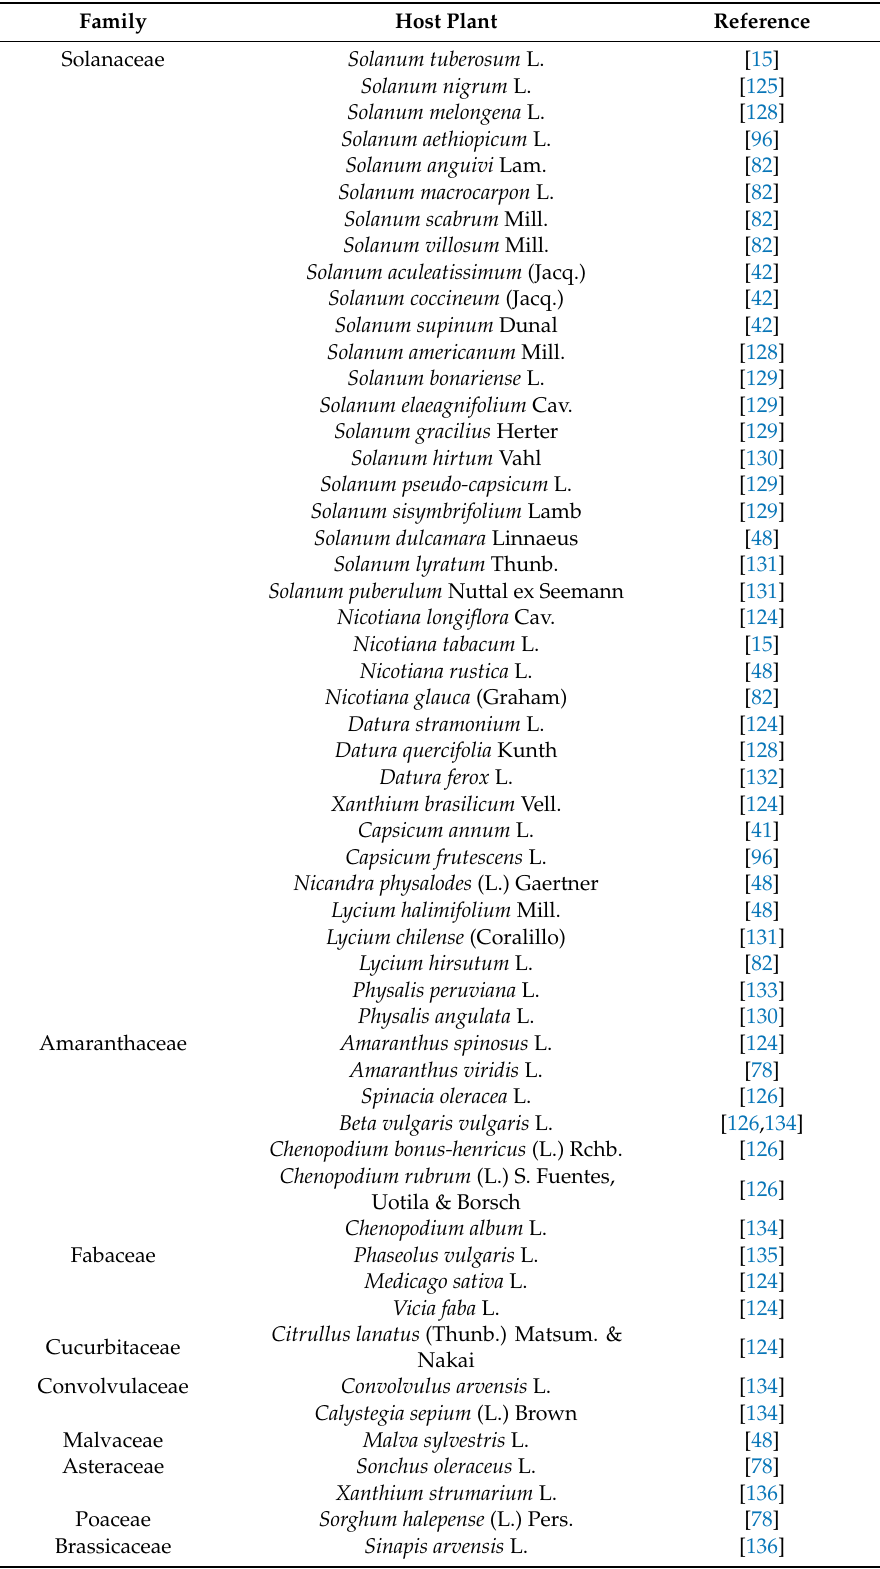
Table 1. Alternative host plants of Tuta absoluta reported in the literature. The list may not be purely exhaustive but was compiled using the literature available at the time of